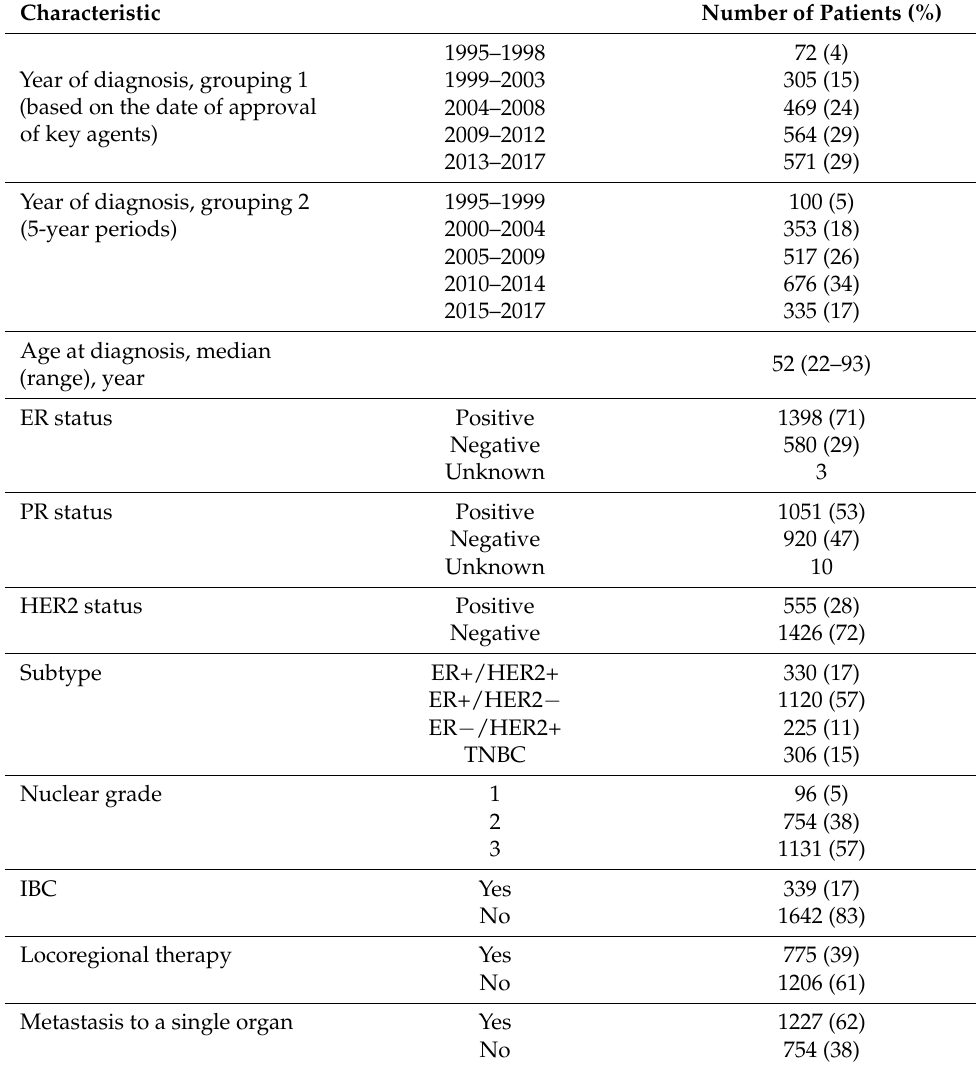
Table 1. Patient characteristics (N =